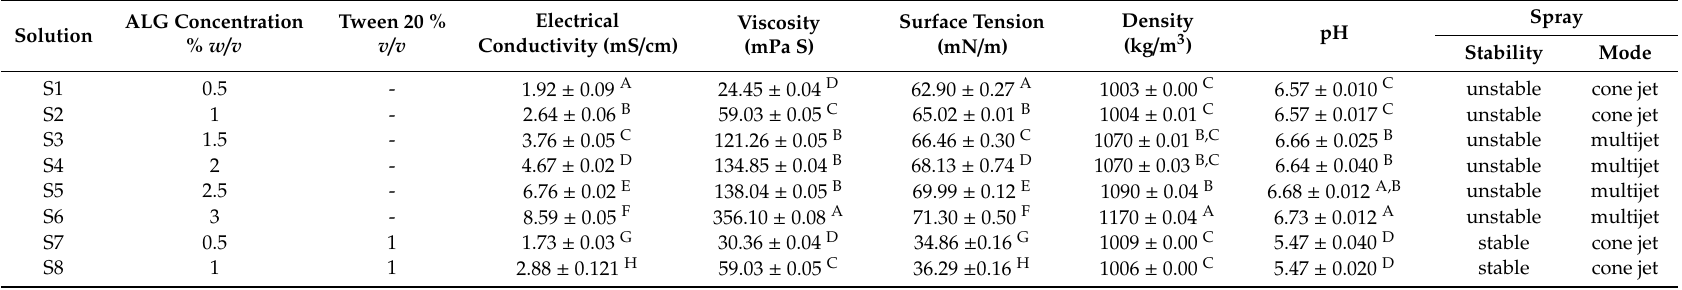
Table 1. Composition of alginate (ALG) solutions and their physiochemical properties. Superscript letters denote significance, whereby groups that do not share a letter are significantly di ff erent p < 0.05 ( n =